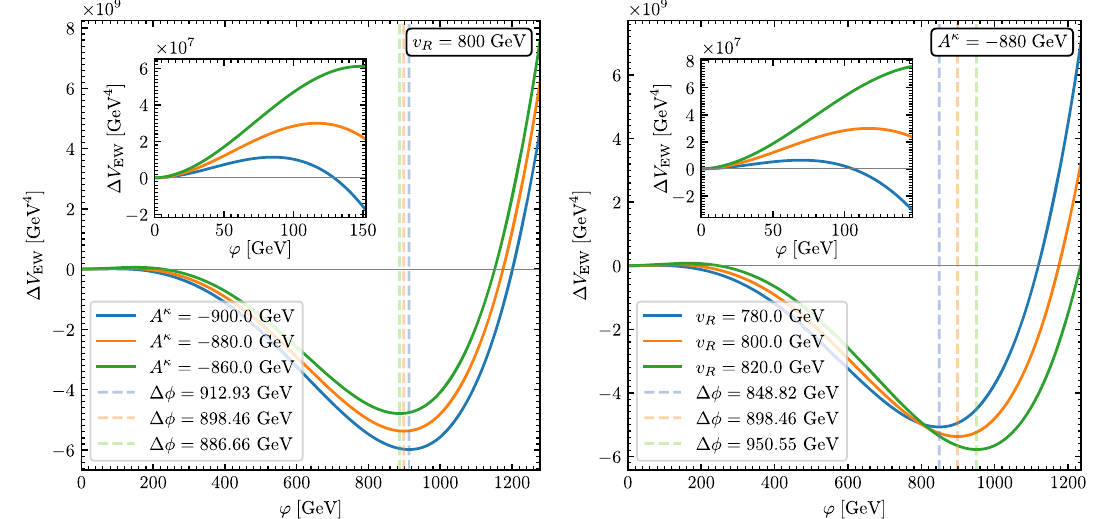
Fig. 3 (cid:11) V EW along the straight path connecting the EW minimum and the most dangerous unphysical minimum for different values of A κ and v iR (right). Also indicated are the field space distances (cid:11)φ with vertical dashed